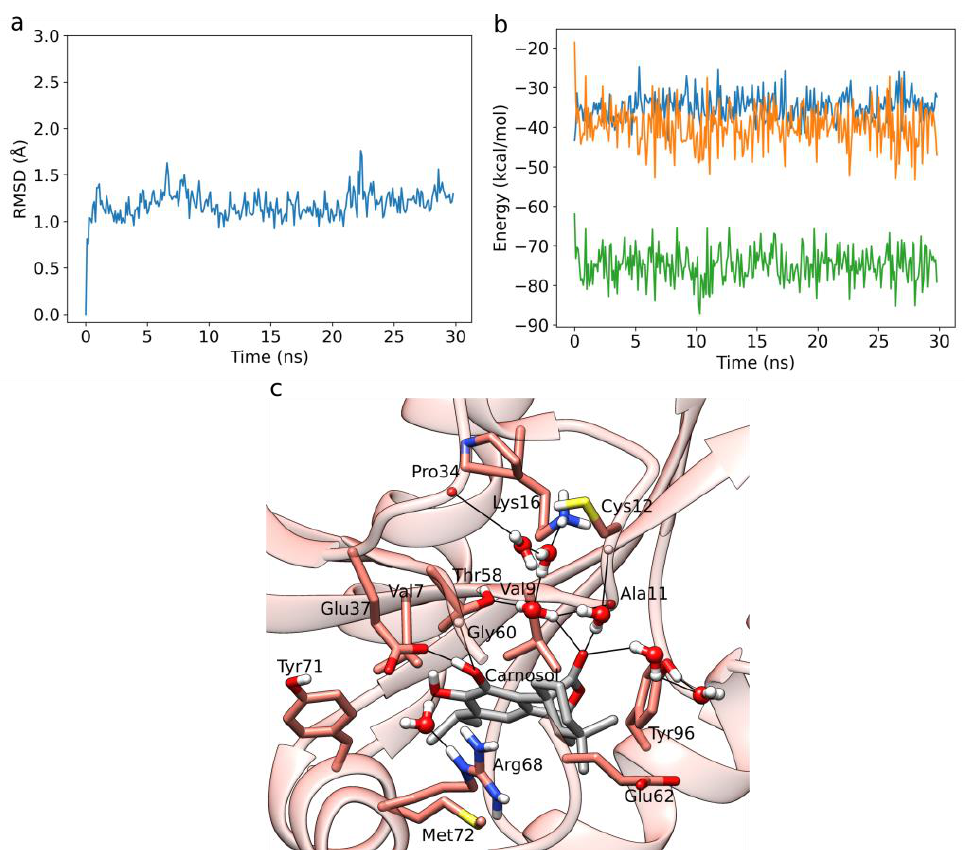
Figure 5. MD simulation of carnosol bound to K-RAS. ( a ) RMSD of the protein backbone of the analyzed MD simulation. ( b ) Interaction energy analysis describing the binding between carnosol and K-RAS as observed in the MD simulation. ( c ) Carnosol forms a stable H-bond network in the K-RAS binding site. Hydrogen bonds are shown with black lines. The remaining amino-acid residues displayed with sticks form hydrophobic contacts with the ligand. We show stable H-bonds and hydrophobic interactions with an occupancy of at least 50%. Table 2. The average electrostatic and van der Waals nonbonded contributions of carnosic acid, carnosol, and rosmanol to K-RAS binding, along with the binding free energies calculated using the LIE method. The standard LIE α and β parameters obtained from the work of Hansson et al. [48] were